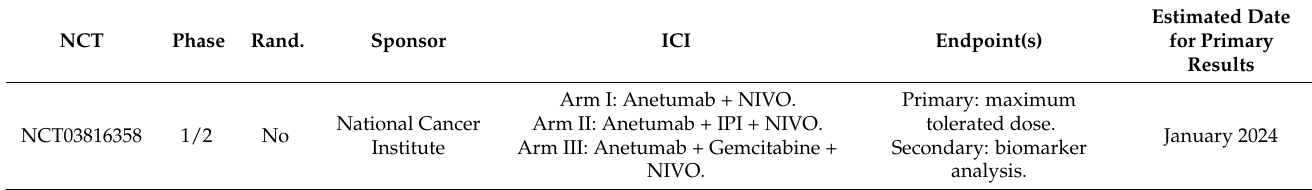
Table 1. List of currently recruiting multicenter clinical trials determining immune-checkpoint inhibitors in patients with pancreatic